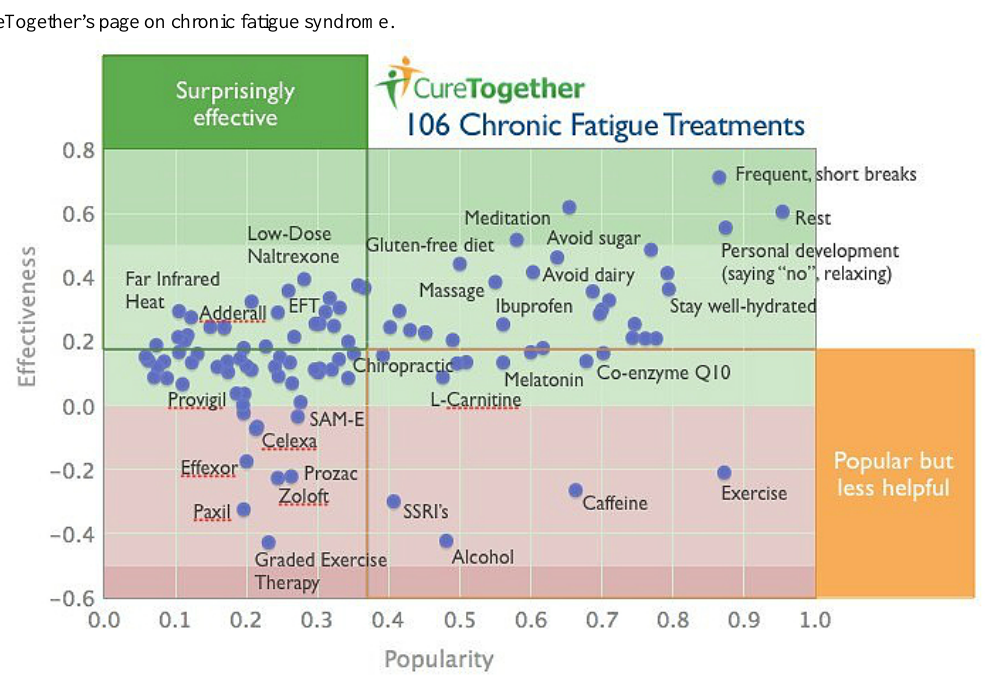
Figure 4. CureTogether’s page on chronic fatigue